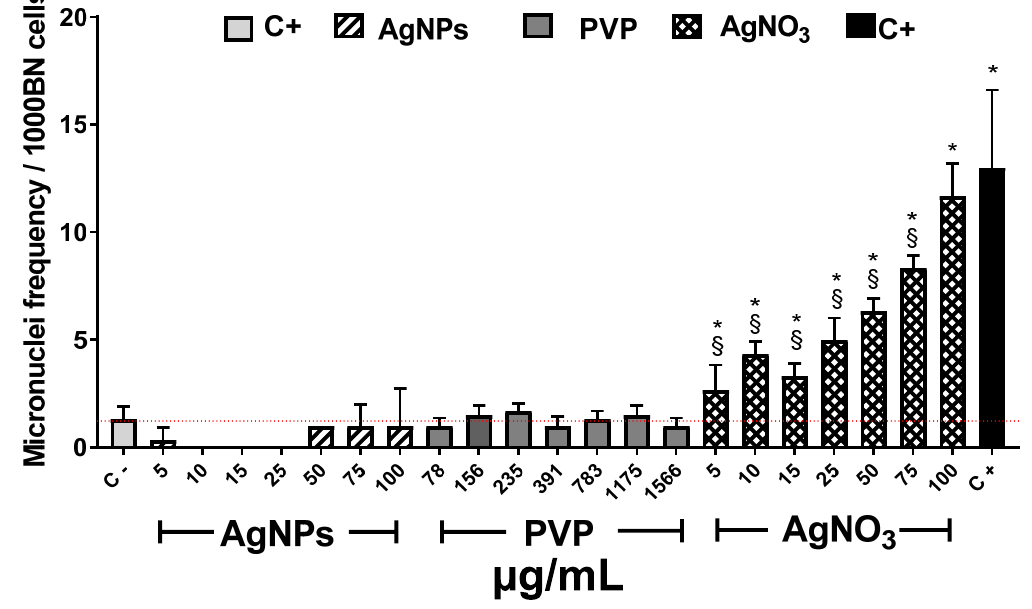
Figure 6. Micronuclei frequency (MN) on Allium cepa root exposed to different stimuli. The MNi frequency was recorded after 72 h exposure to different concentrations of AgNPs (lined), PVP (dark gray), and AgNO 3 (grid). C − corresponds to untreated plants (light gray) and C+ to those exposed to 0.37 µg/mL of sodium arsenite (black). * Indicates significative differences with the negative control ( p < 0.05); § indicates significative differences with the positive control ( p < 0.05).